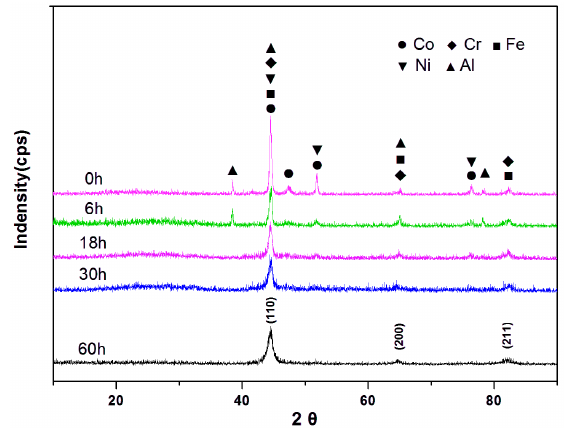
Figure 1. XRD patterns of CoCrFeNiAl HEA during 60 h milling.